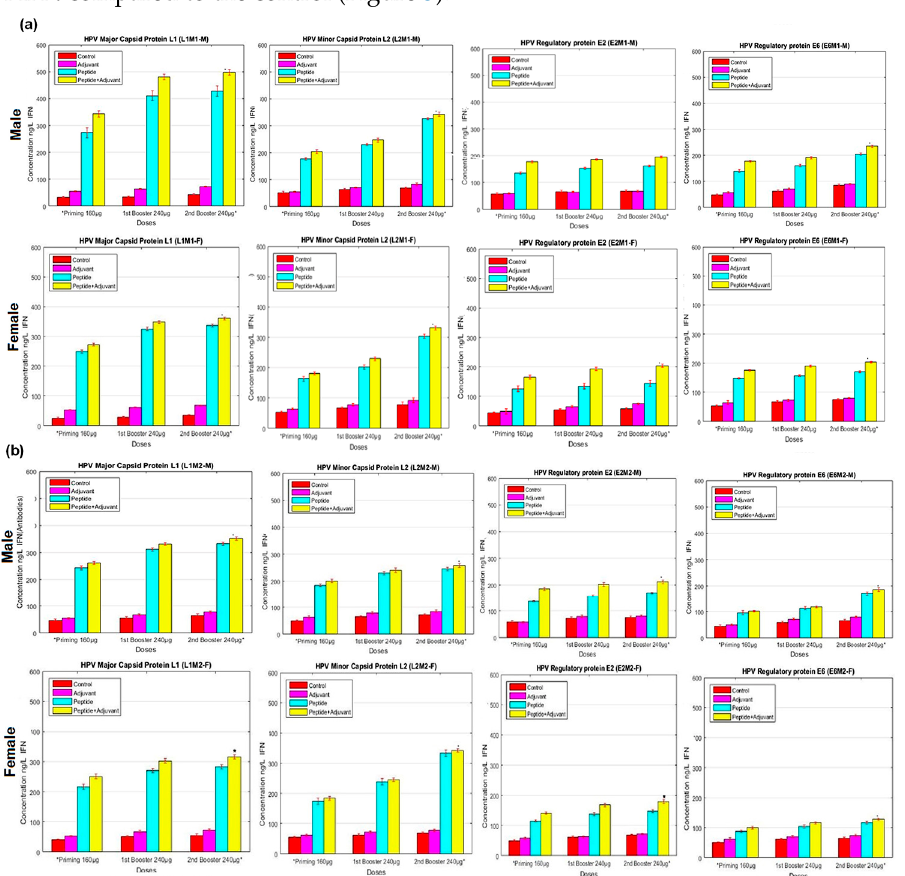
Figure 5. IFN- γ analysis of ( a ) MHC Class-I ( b ) MHC Class-II, antigenic peptides measured by ELISA assays. Blood samples of experimental male and female rats immunized with potential epitopes (individual peptides) emulsified with and without adjuvant at primary, first and second booster doses. The titer rate of IFN- γ is given in ng/L. All data were compared to control group. Bars represent ‘mean; which is signified (*) with p -value (<0.01) and standard deviation (SD).